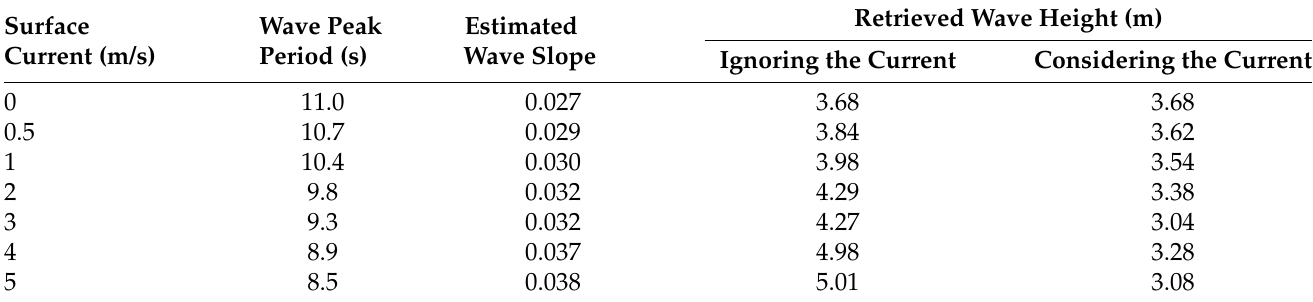
Table 1. The retrieved significant wave height with different sea surface